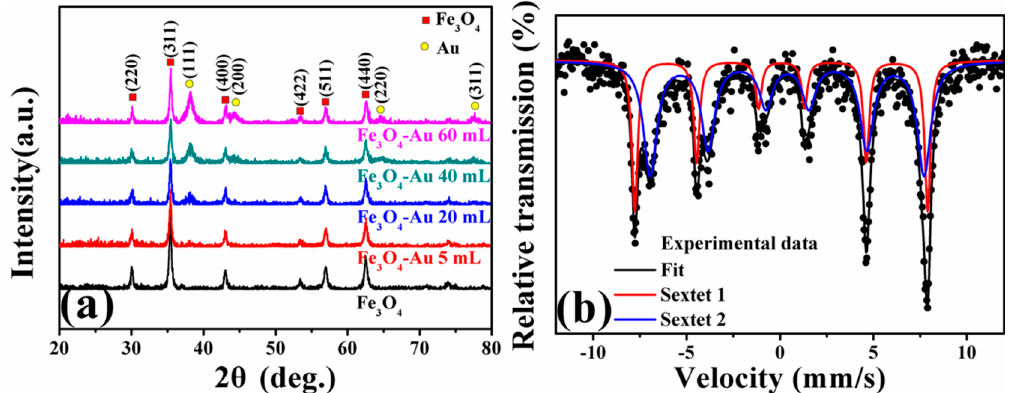
Figure 2. XRD patterns of the as-prepared pure Fe 3 O 4 hollow microspheres and Fe 3 O 4 -Au magnetic nanocomposites with the different addition quantities of the gold seed colloids (Fe 3 O 4 -Au 5 mL, Fe 3 O 4 -Au 20 mL, Fe 3 O 4 -Au 40 mL and Fe 3 O 4 -Au 60 mL) ( a ); Mössbauer spectra of pure Fe 3 O 4 hollow microsphere ( b ).